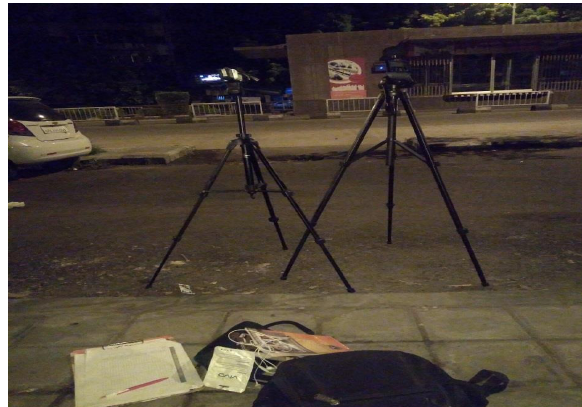
Figure 2: View of location 1-A 1